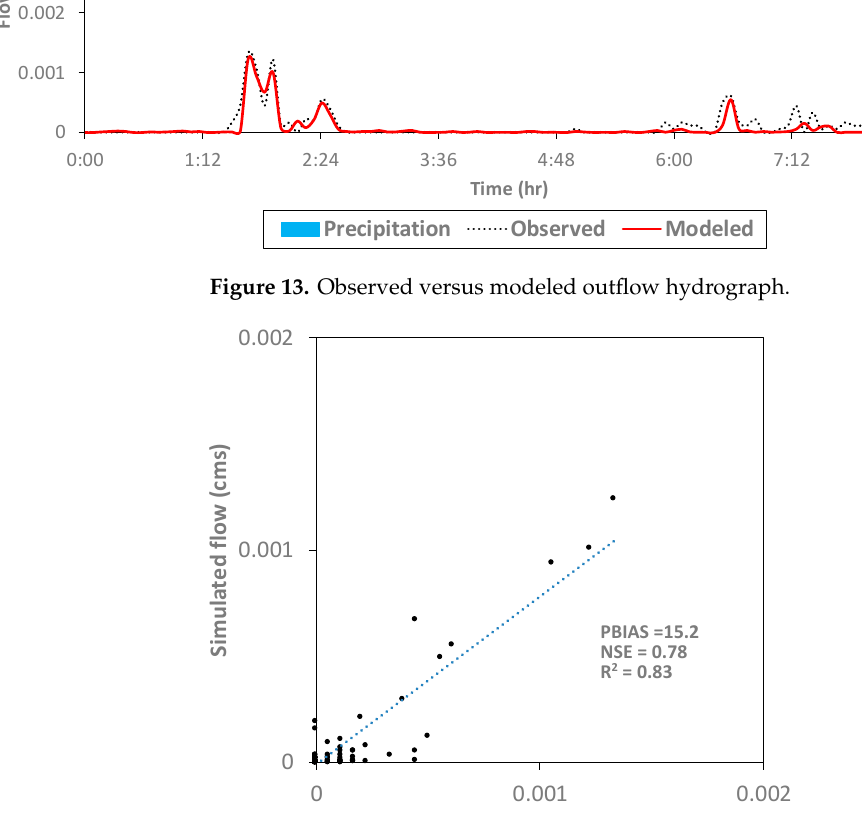
Figure 14. Comparison of green roof modelling with observed data.